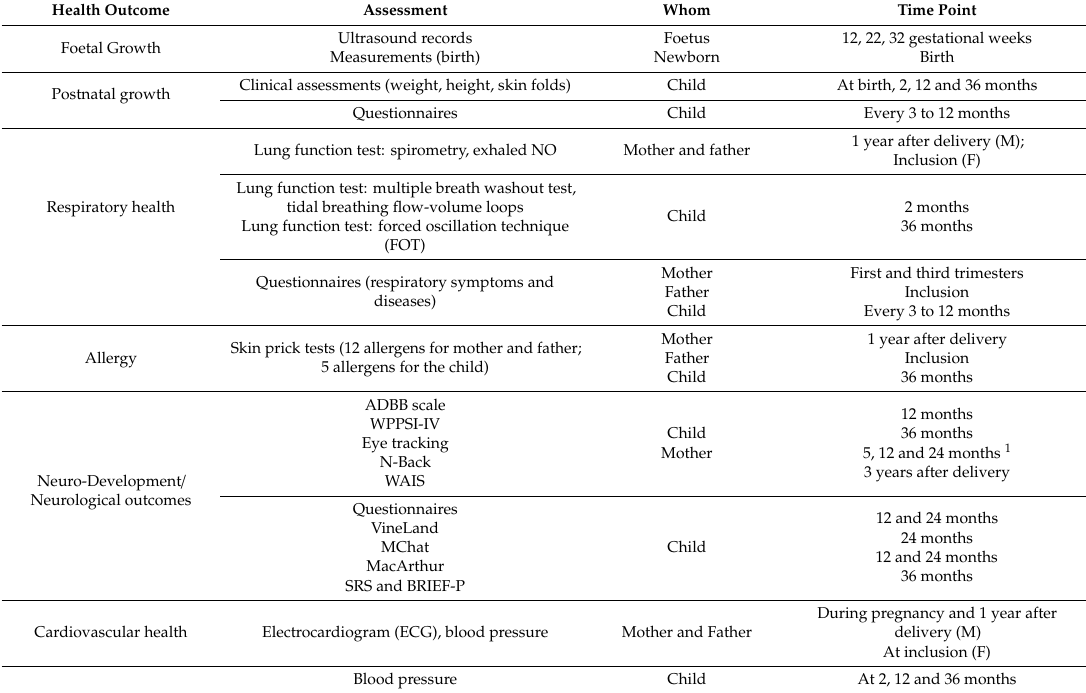
Table 5. Health outcomes assessed in parents, foetuses and children in SEPAGES mother-child cohort. Health Outcome Assessment